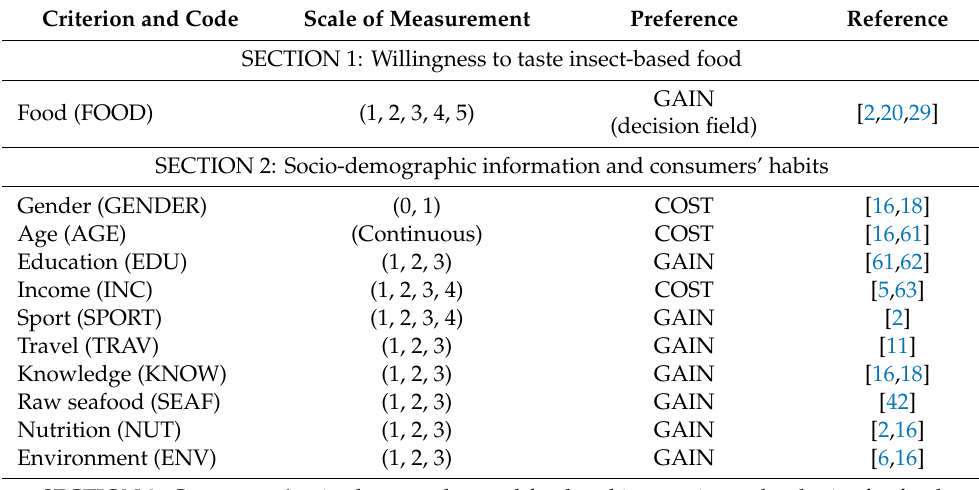
Table 1. List of criteria with associated codes, scale of measurement and preference information according to the relevant scientific literature. Criterion and Code SECTION 1: Willingness to taste insect-based